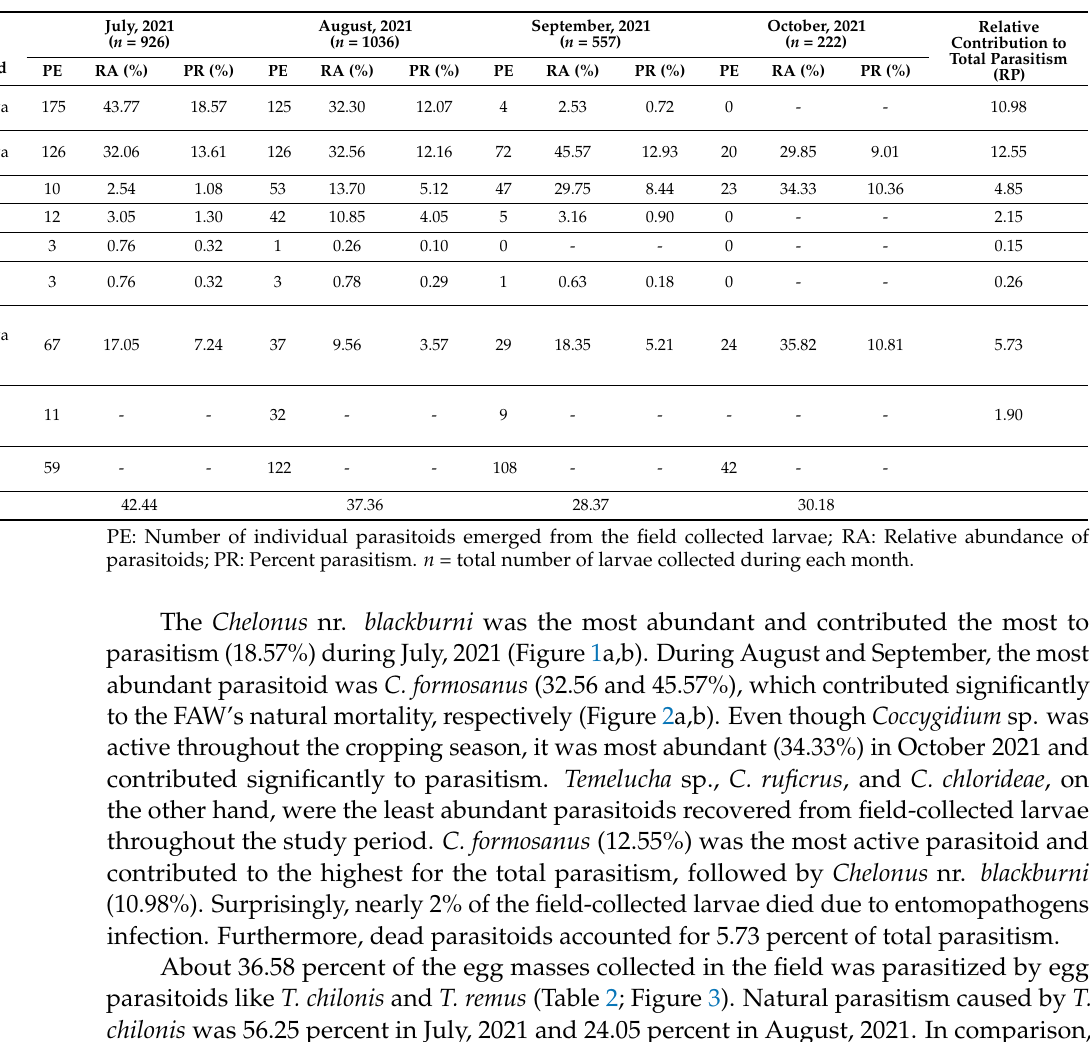
Table 1. Relative abundance and parasitism rate of native parasitoids on S. frugiperda in New Delhi,